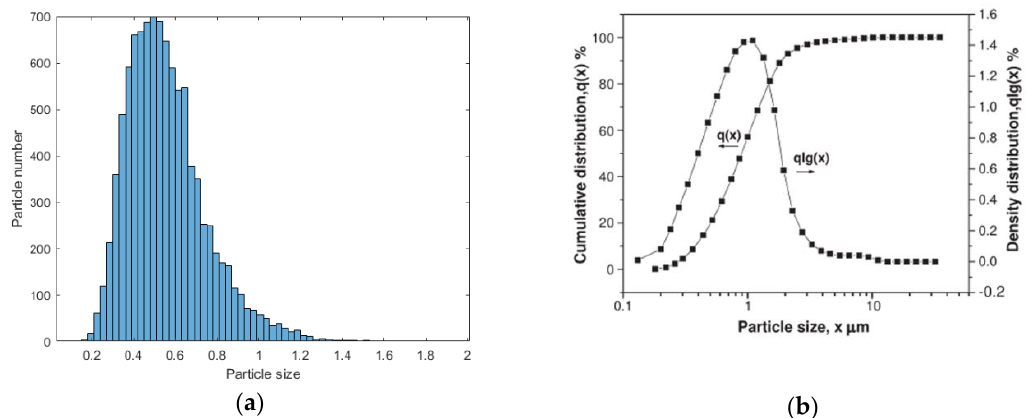
Figure 1. ( a ) The particle size distribution of model for PZT matrix ferroelectric composites. ( b ) The particle size distribution of the PZT (piezoelectric ceramic) powder [31]. The generated RCPS model is shown in Figure 2.